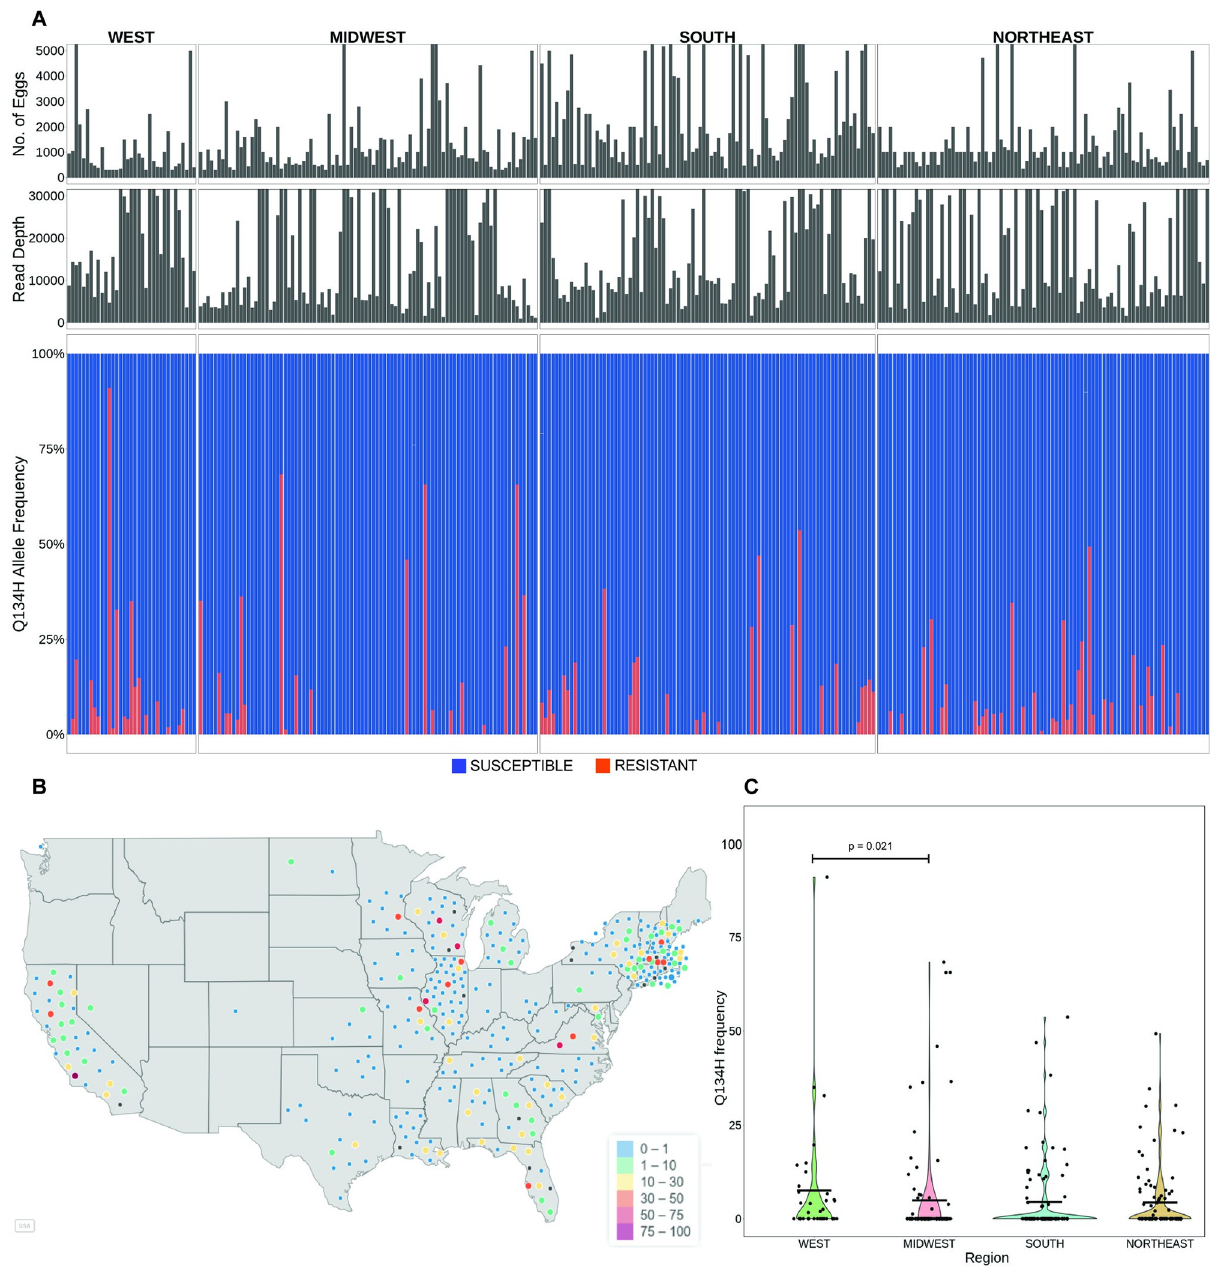
Fig 5. Frequency and prevalence of the novel Q134H(CAA > CAT) benzimidazole resistance mutation in A . caninum from pet dogs across the USA. (A): Deep amplicon sequencing data of the 293 bp isotype-1 β -tubulin fragment of A . caninum from the 314/ 328 individual samples across the USA. The top panel is a bar chart showing the number of eggs used to make each genomic DNA preparation, in the middle is a bar chart showing the mapped read depth for each sample, and the lower chart shows the relative frequency of the Q134H(CAA > CAT) mutation. Red bars indicate the 134H (CAT) resistance allele and the blue bars indicate the 134Q(CAA) susceptible allele. (B): Geographical distribution of the individual samples and the frequency of the 134H(CAT) resistance allele. The map of the USA was generated using the maps() package in R and is available from: https://rdrr.io/ cran/maps/man/usa.html. The color of each circle indicates the frequency of the resistance mutation in each sample, ranging from 0–100%. (C): Violin Plot of the 134H(CAT) resistance allele frequencies from samples in each of the four geographical regions. The mean frequency is indicated by a horizontal line and any statistically significant differences calculated using the pairwise Wilcoxon rank sum test (p < 0.05) between the regions are indicated (p-value > 0.05 not indicated).